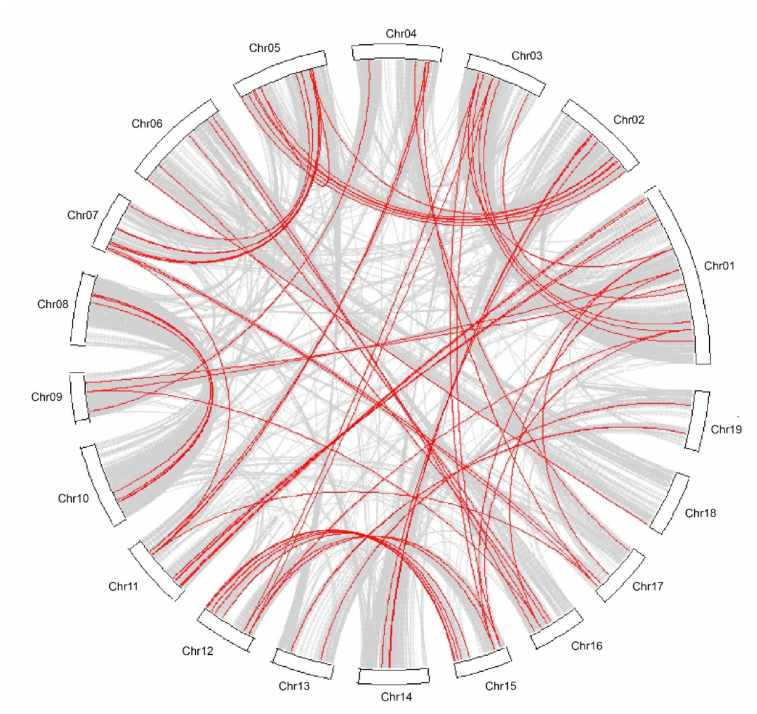
Figure 3. Duplicated blocks in Populus genome. The syntenic relationships among 19 Populus LGs are detected using the MCScanX programme. The colinear blocks of Populus genome are shown in grey connecting lines and the colinear blocks of NAC genes are marked by red connecting